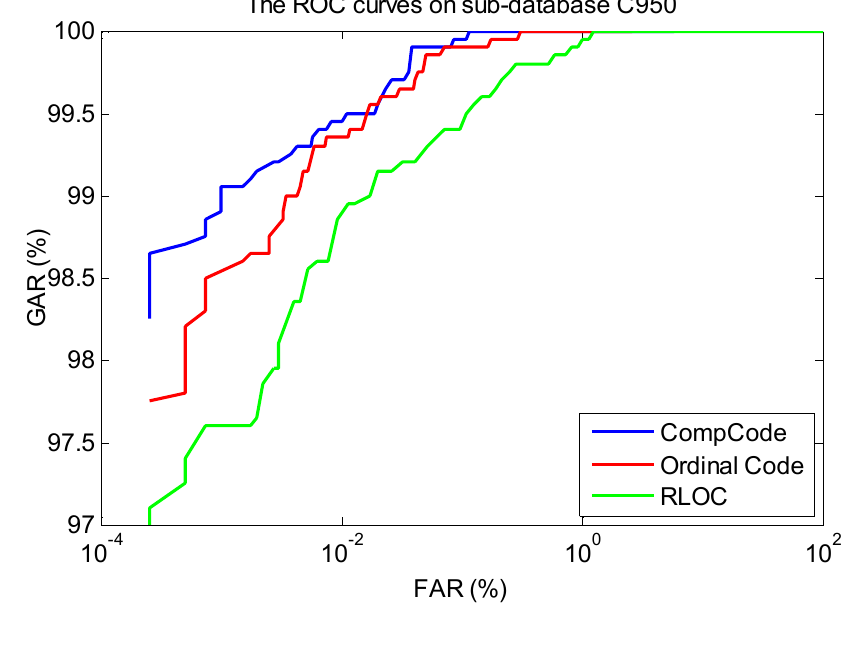
Figure 12. The ROC curves of methods Comp Code, Ordinal Code and RLOC on sub-database M525 (using the 1~3 samples of the first session as the training